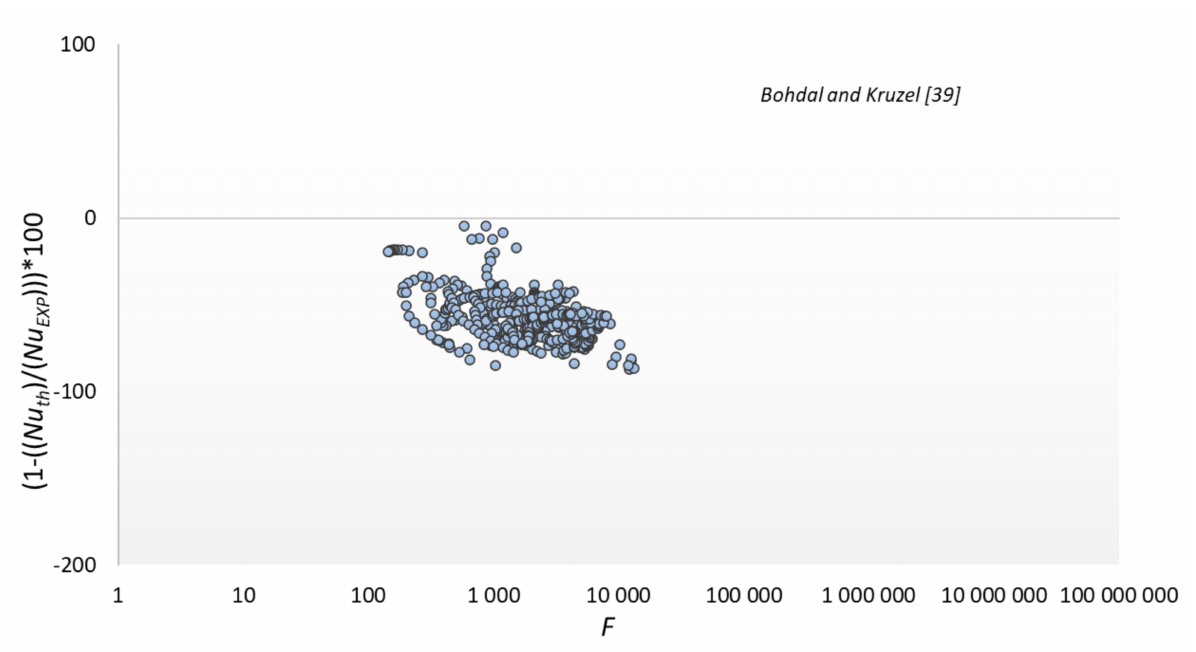
Figure 13. Comparison of experimental data to the model of Bohdal and Kruzel (18).